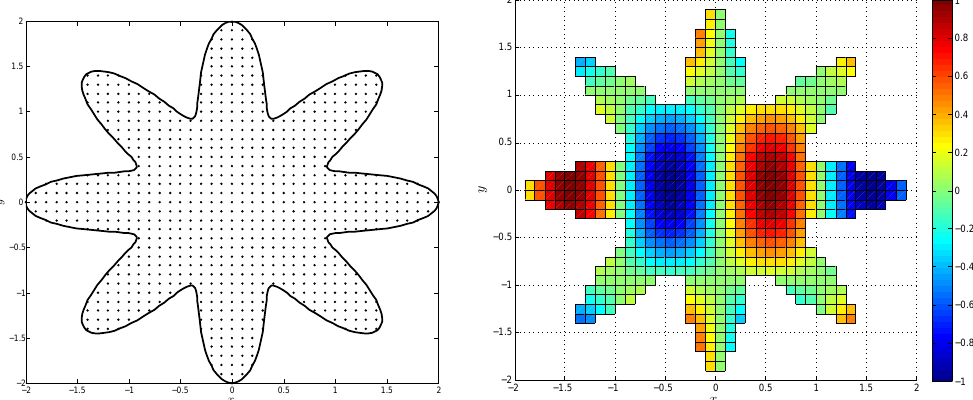
Figure 5. Computational domain x -axis [ − 2.5,2.5 ] and y -axis [ − 2.5,2.5 ] ( left ) and numerical solution ( right ) for Problem 2.